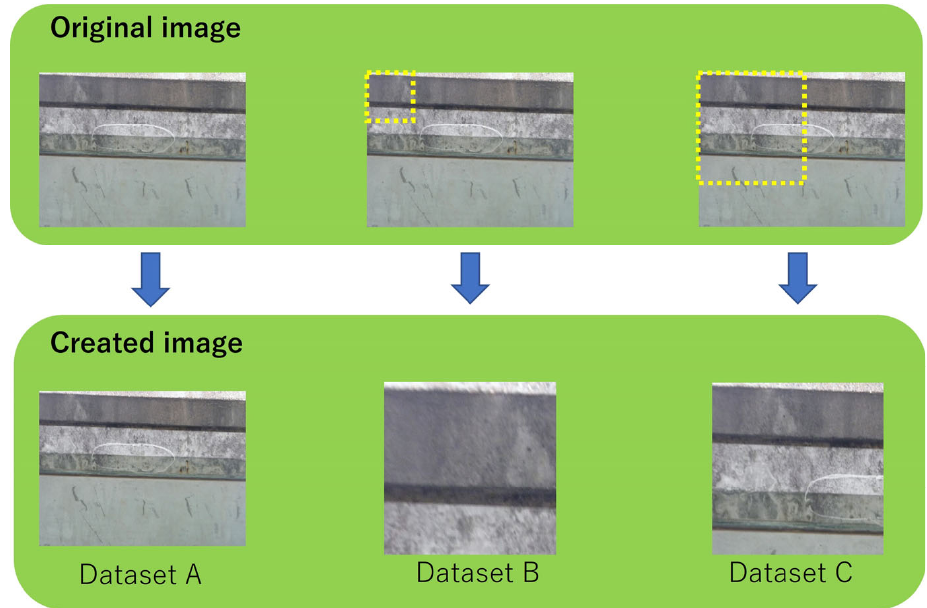
Figure 3. Example of each dataset image created by the original image.